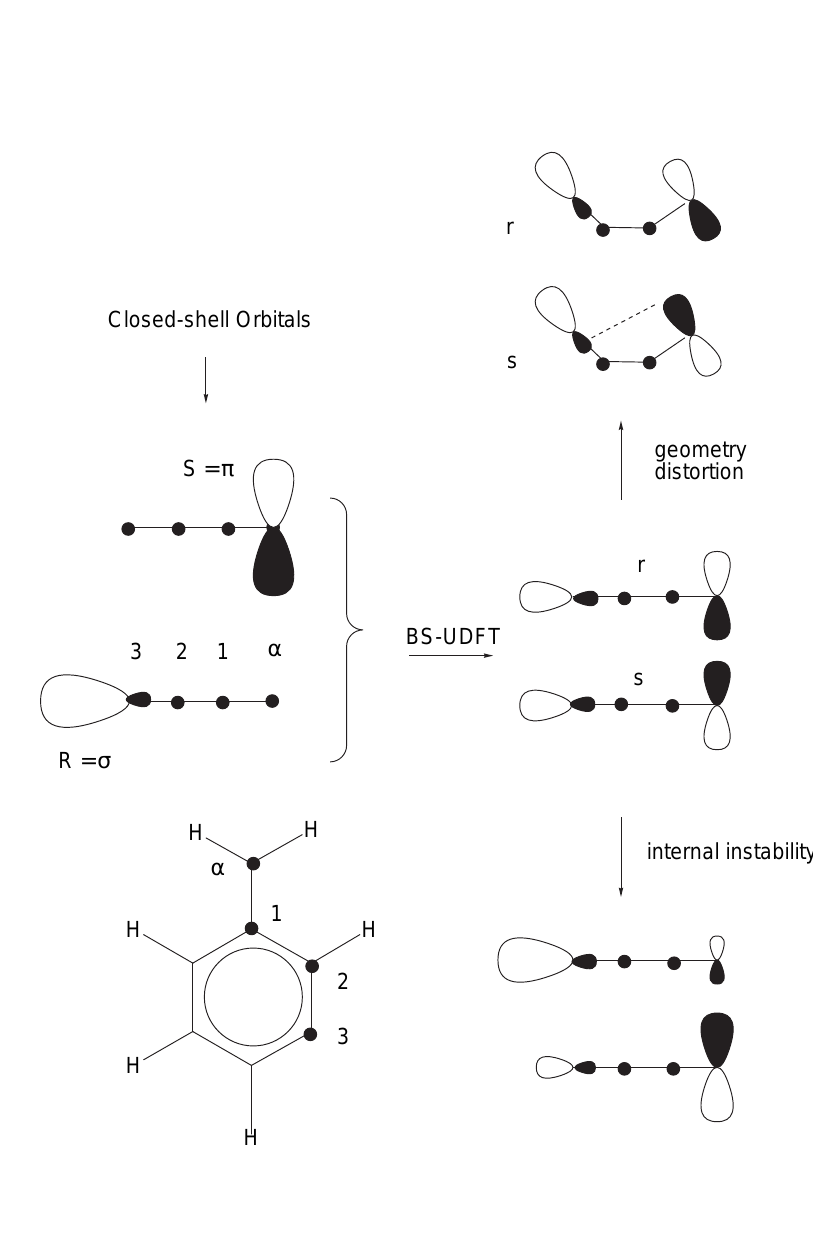
Figure 4: Schematic representation of open-shell orbitals ϕ within the BS-UDFT approach (right side, middle), after repeated mixing because of internal instability (right side, bottom), and after mixing caused by geometry distortions (right side, top). Atoms C α , C1, C2, and C3 are represented by dots. The geometry distortion is strongly exaggerated to represent orbital mixing